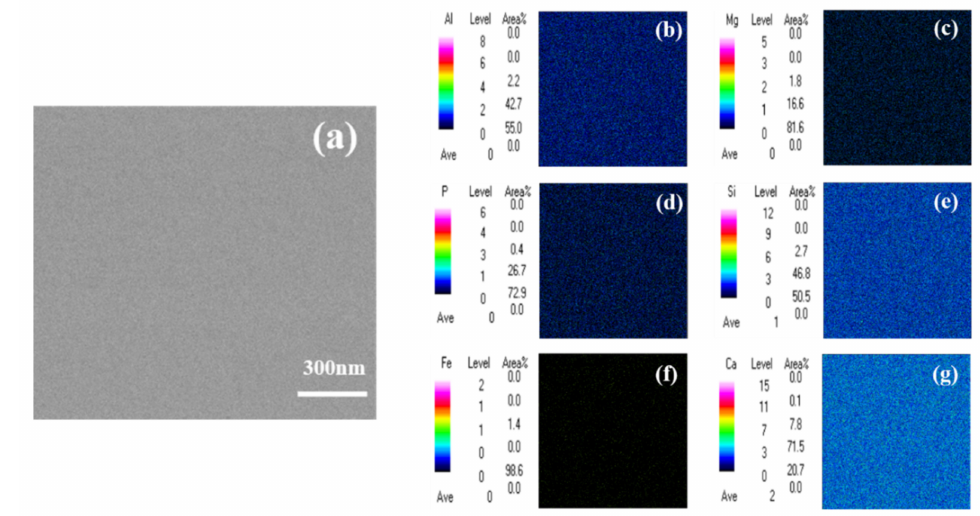
Figure 5. EMPA elemental mappings of phosphorous slag: ( a ) backscattered electron image; ( b ) Al; ( c ) Mg; ( d ) P; ( e ) Si; ( f ) Fe; ( g )